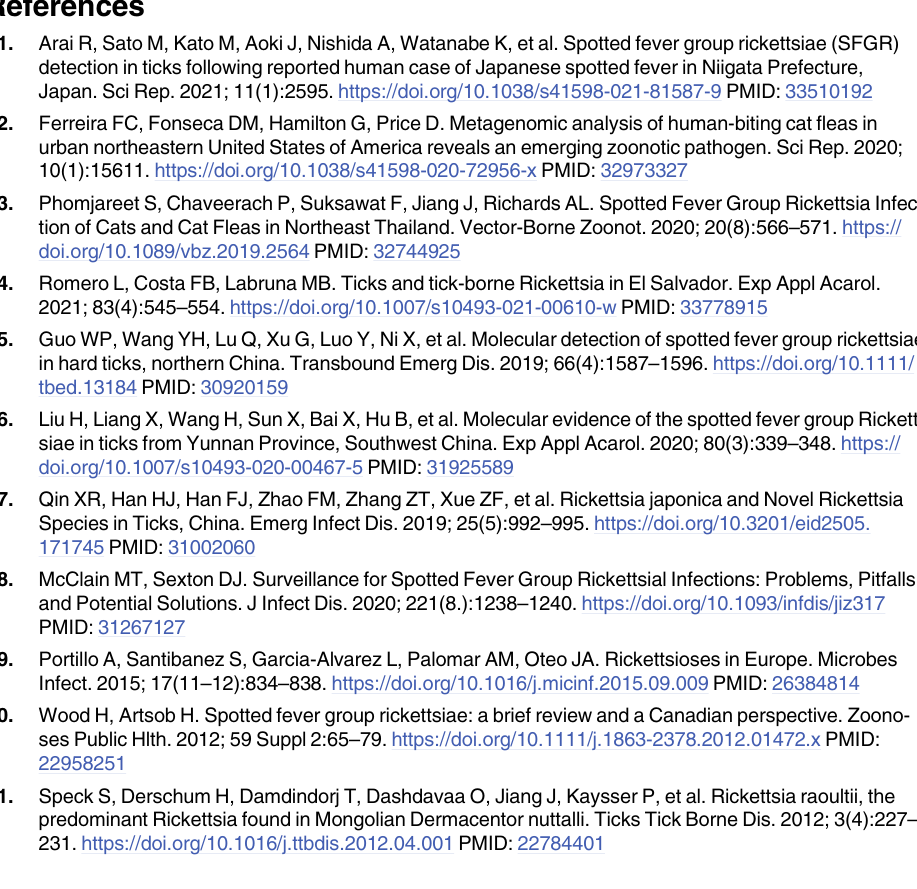
S3 Fig. Sequences alignment of partial samples of Rickettsia raoultii by DNAMAN. The sequence alignment results in GenBank: i.e. accession no: AH015610.2, CP010969.1, AH009131.2, KM288513.1, KM288500.1, KM288495.1, MK304548.1, HQ232221.1, OL348252.1, JX683119.1. S4 Fig. Phylogenetic tree based on the ompA gene of Rickettsia raoultii . HLBE: Hulun Buir City of Inner Mongolia,